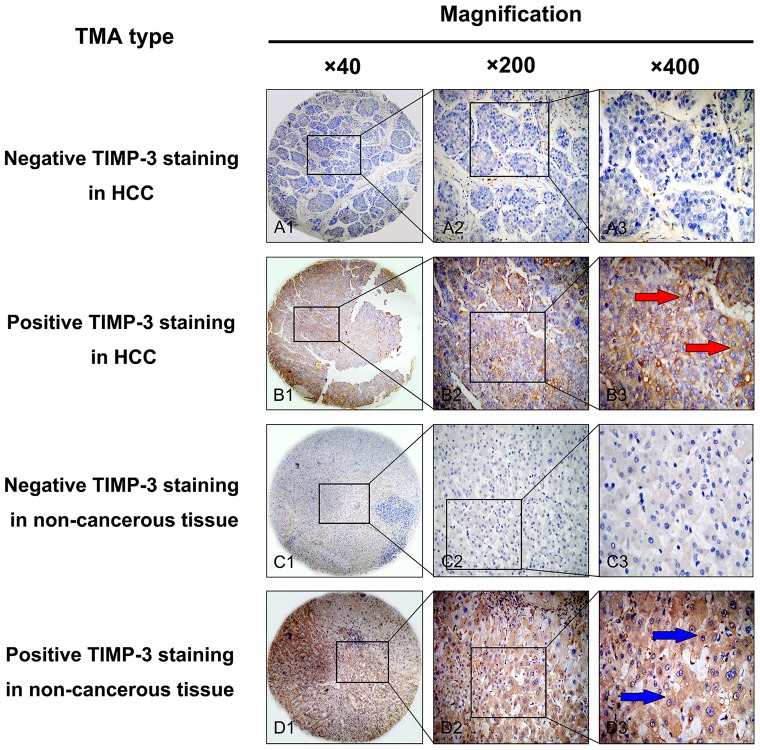
Representative staining pattern of TIMP-3 protein expression in HCC and corresponding non-cancerous tissues in a tissue microarray (TMA).A1, A2 and A3. Negative immunohistochemical (IHC) staining of TIMP-3 in HCC samples. B1, B2 and B3. Positive IHC staining of TIMP-3 in HCC samples. The red arrow highlights positive staining in the cytoplasm of cancer cells. C1, C2 and C3. Negative IHC staining of TIMP-3 in non-cancerous tissue samples. D1, D2 and D3. Positive IHC staining of TIMP-3 in non-cancerous tissue samples. The blue arrow highlights positive staining in the cytoplasm of non-cancerous cells. Original magnification ×40 in A1, B1, C1 and D1; ×200 in A2, B2, C2 and D2; ×400 in A3, B3, C3 and D3.